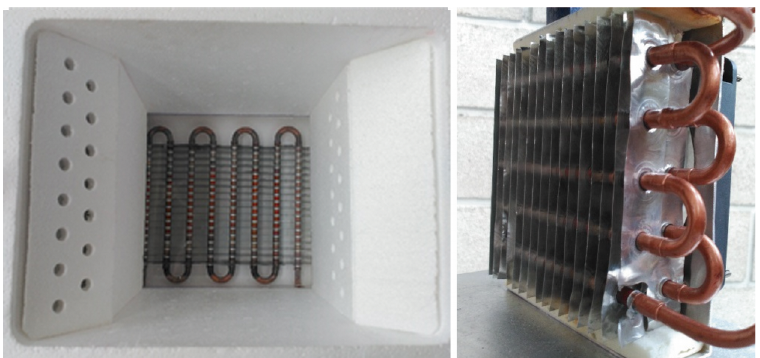
Figure 7. (a) Evaporator of the cooling system, (b)